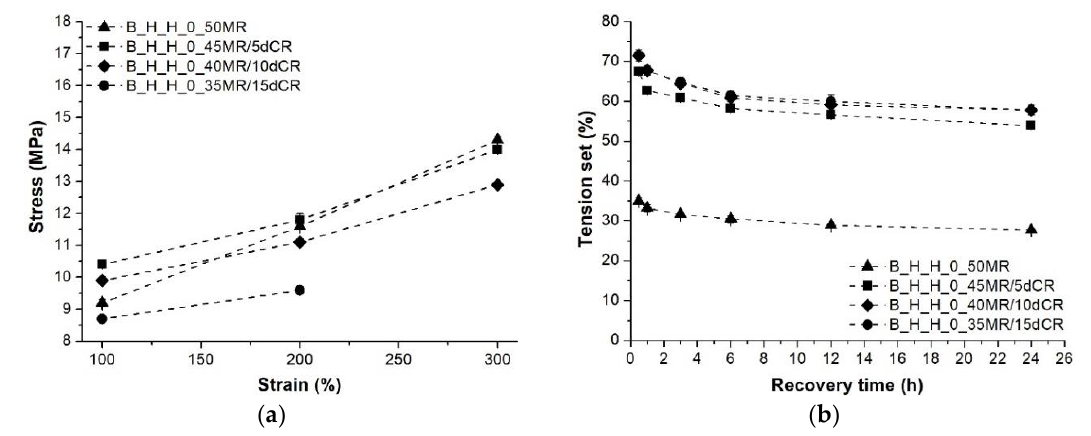
Figure 8. Stress at 100%, 200% and 300% elongation and the tension set of the TDVs produced with different dCR content: ( a ) Stress; ( b ) Tension set.